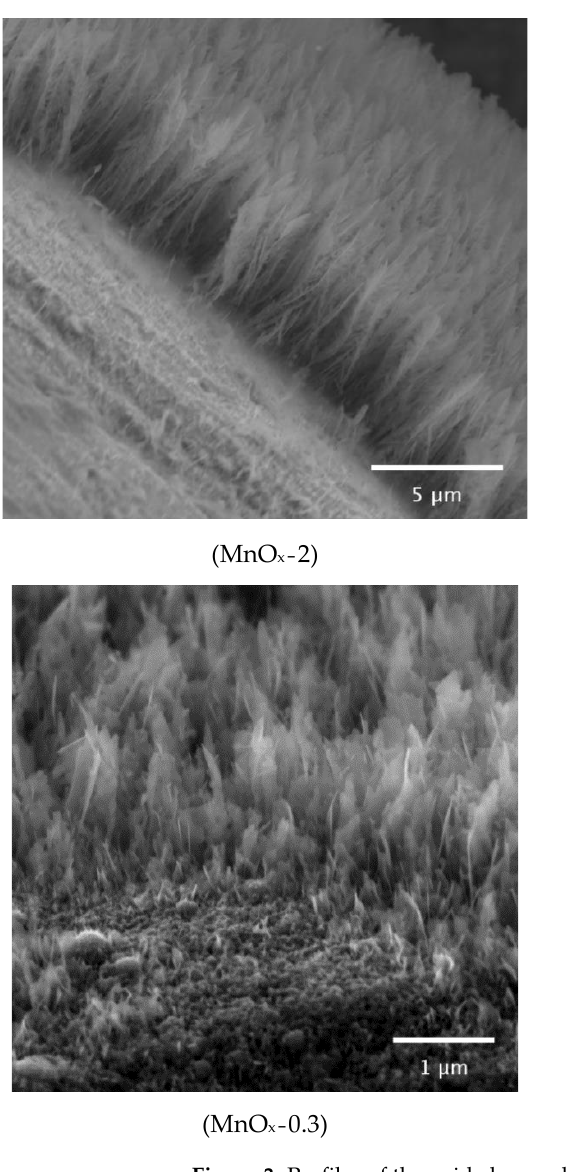
Figure 3. Profiles of the oxide layers deposited on stainless steel supports.